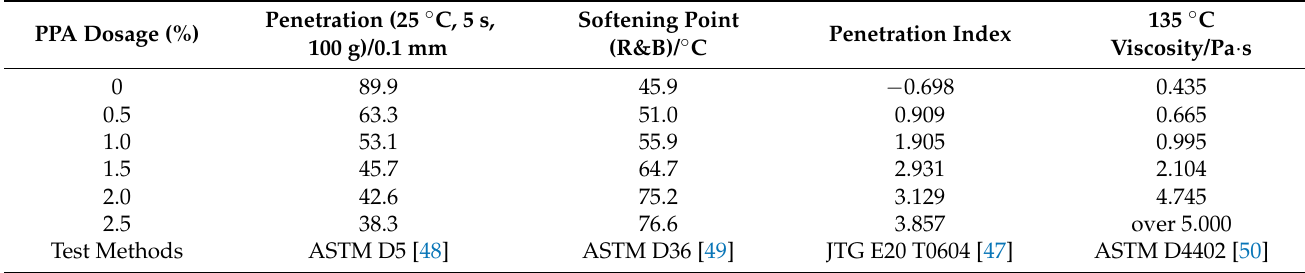
Table 1. Basic physical properties of six kinds of asphalt